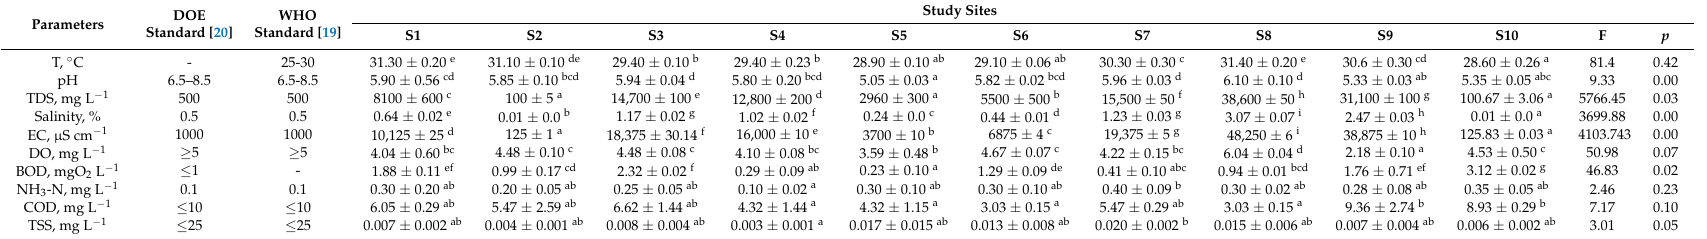
Table 5. Descriptive analysis for the physicochemical parameters of rivers in Bintulu, Sarawak, Borneo.